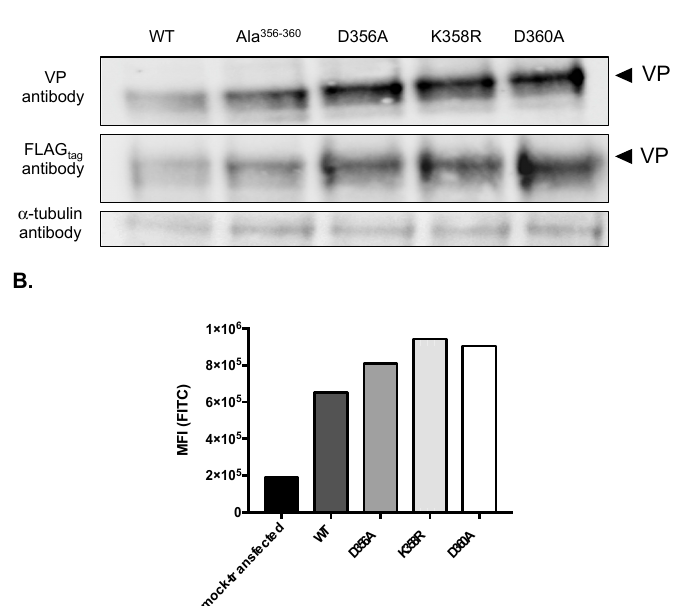
Figure 2. Expression of mutant rVPs bearing the D356A, K358R, and D360A substitutions in A549 cells. A549 cells were transfected at 18 h with pcDNA3/rVP (WT), pcDNA3/rVP-Ala 356–360 (Ala 356–360 ), pcDNA3/rVP-D356A (D356A), pcDNA3/rVP-K358R (K358R), or pcDNA3/rVP-D360A (D360A). In ( A ), an immunoblot assay was performed with anti-FLAG tag or anti-VP antibody. The α -tubulin protein served as a protein loading control. In ( B ), FACS analysis using anti-FLAG tag antibody was performed on mock-transfected (control) or transfected cells and the mean of fluorescence intensity (MFI) of rVP-positive cells is shown.